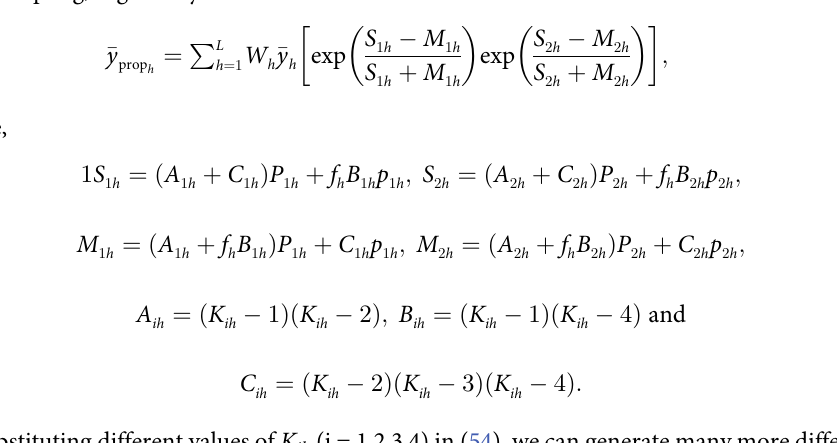
Proposed class of estimators In the lines of Shukla et al. [12], we proposed a generalized class of estimators in stratified ran- dom sampling, is given by: